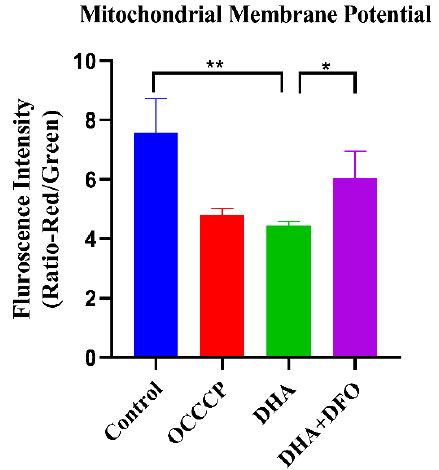
Figure 3. DHA treatment reduces mitochondrial membrane potential. Freshly released tachyzoites were treated with 4 × EC50 (0.88 μM) DHA or DHA + 80 μM DFO at 37 °C for 4 h. The FI signals of the mitochondrial membrane potential fluorescent probe JC-10 were then detected. Quantification of the red/green fluorescence intensity ratio was calculated by comparing the red and green chan- nels per 10 5 tachyzoites. OCCCP was treated as a positive control. Student’s t -tests were used to determine statistical significance (** p < 0.01, and * p < 0.05).